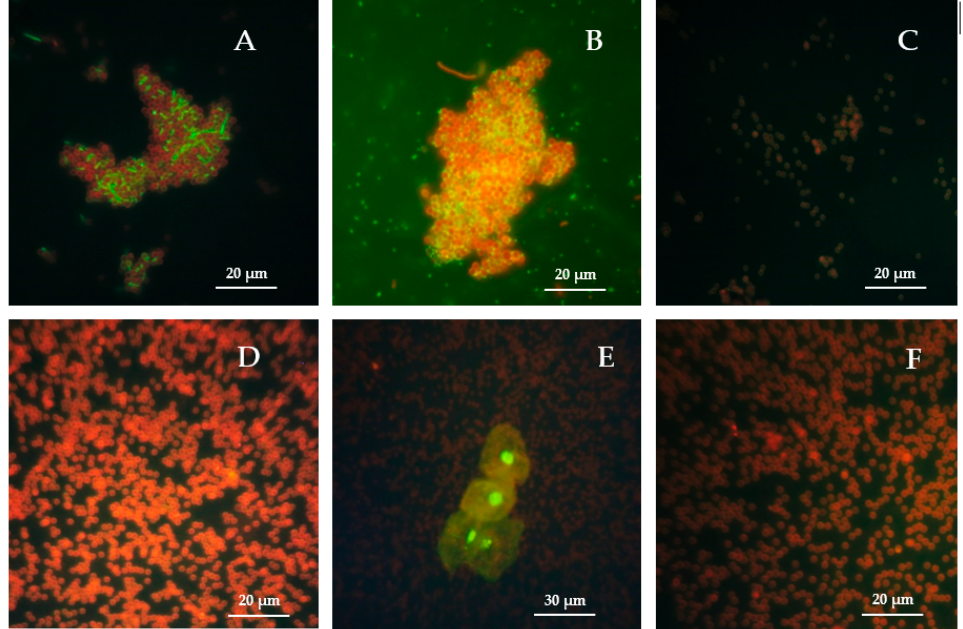
Figure 9. Examples of test kit results on urine samples: ( A – C ) test kit 1 assay of a clinical sample with a dual catheter infection: Proteus and Enterococcus . Anti gram-negative functionalized MB— green-stained bacteria are present in large clusters ( A ); Anti gram-positive functionalized MB— yellow-green-stained bacteria are present in large clusters ( B ); reference non-functionalized MB—no clusters and no bacteria present ( C ). ( D – F ) Test kit 2 sample—negative; Anti- E. coli MB—no clusters and no bacteria present ( D ); MBL MB—no clusters and no bacteria present, although epithelial cells